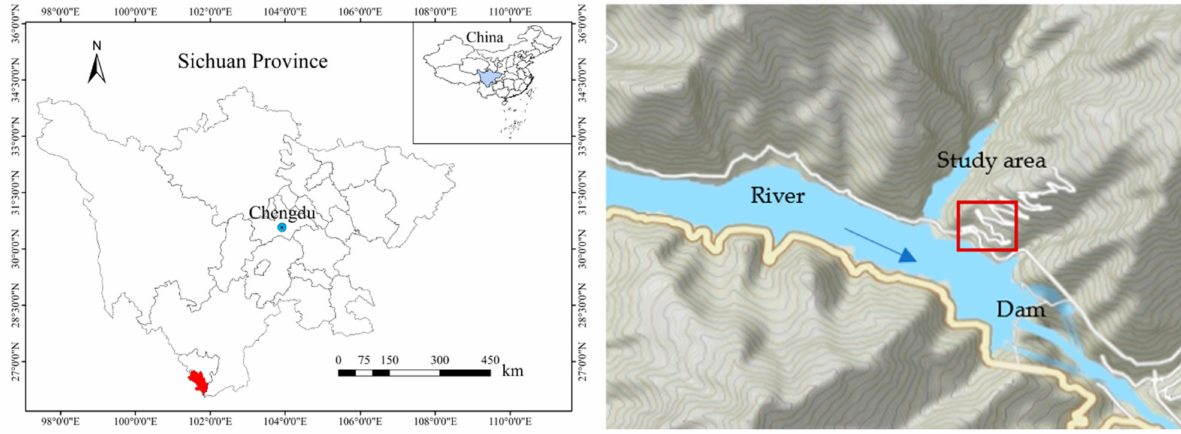
Figure 1. Landslide